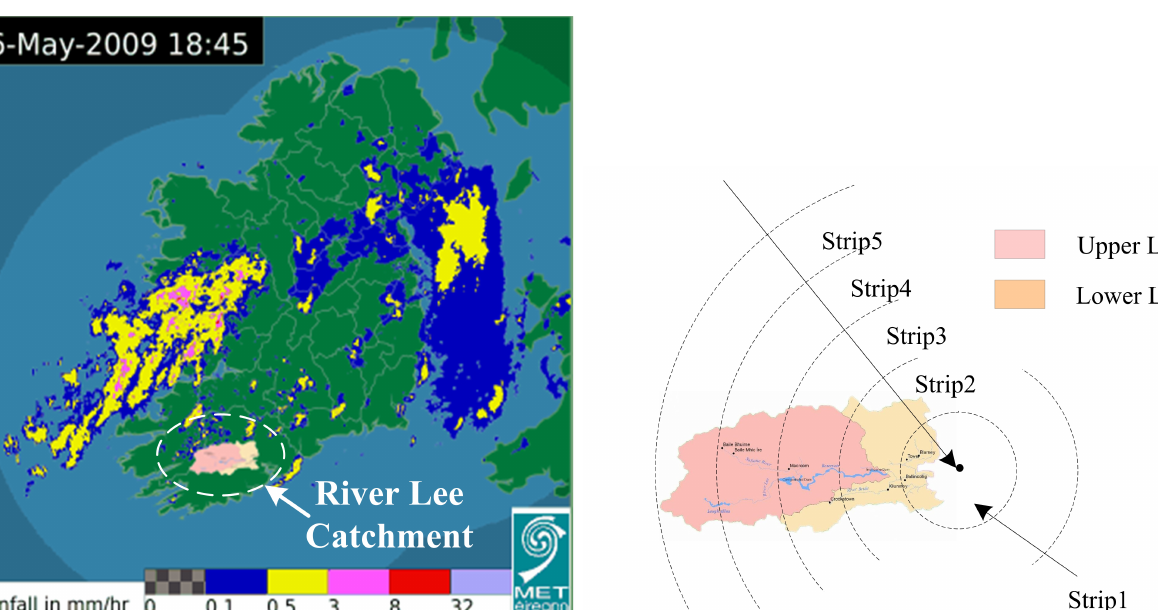
Figure 3. Catchment range for River Lee (left) & strips distribution